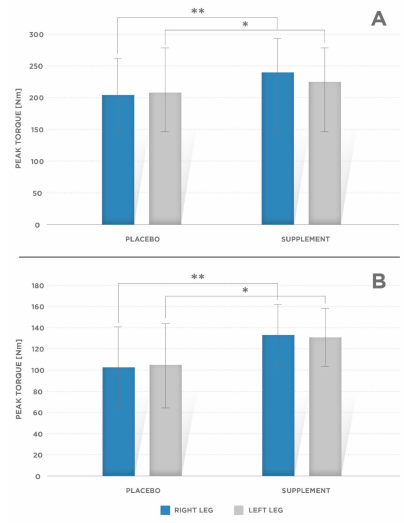
Figure 1. Mean values of torque (T@0.2s) at 60 ◦ / s at 0.2 s for ( A ) the right and left knee extensors. Significant di ff erence was observed for the right leg (** p = 0.001) and left leg (* p = 0.002) and ( B ) for the right and left knee flexors. Significant di ff erence was observed for the right leg (** p = 0.001) and left leg (* p = 0.002). Error bars indicate standard deviation